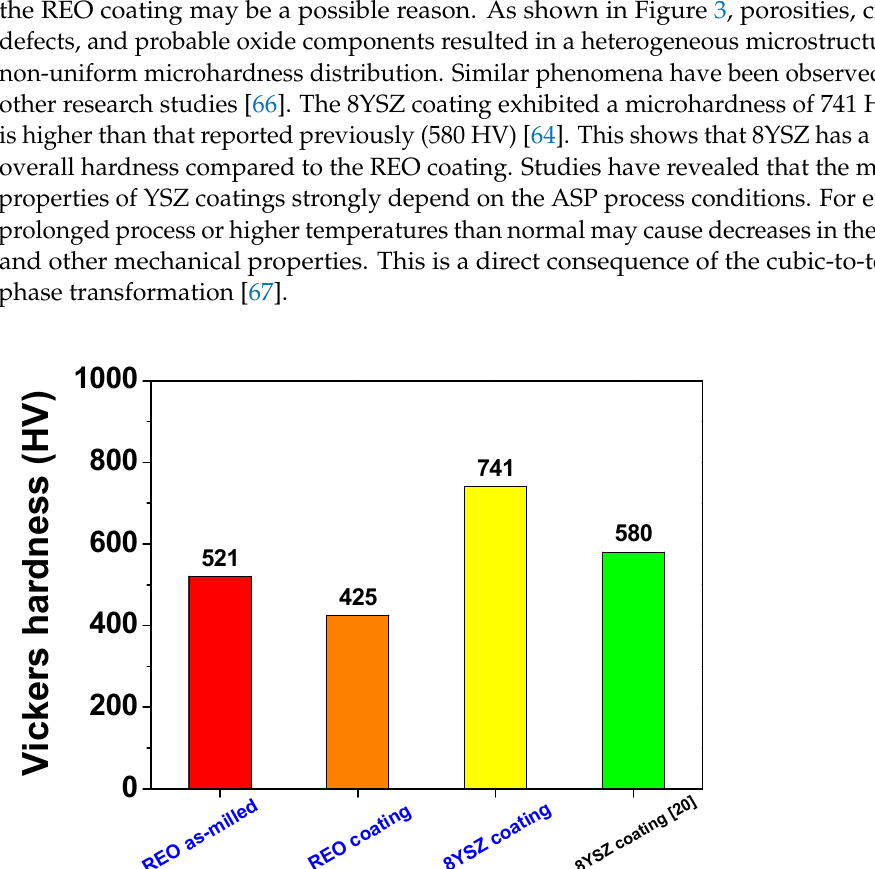
Figure 5. Line scans obtained from the cross-section of the REO coating.